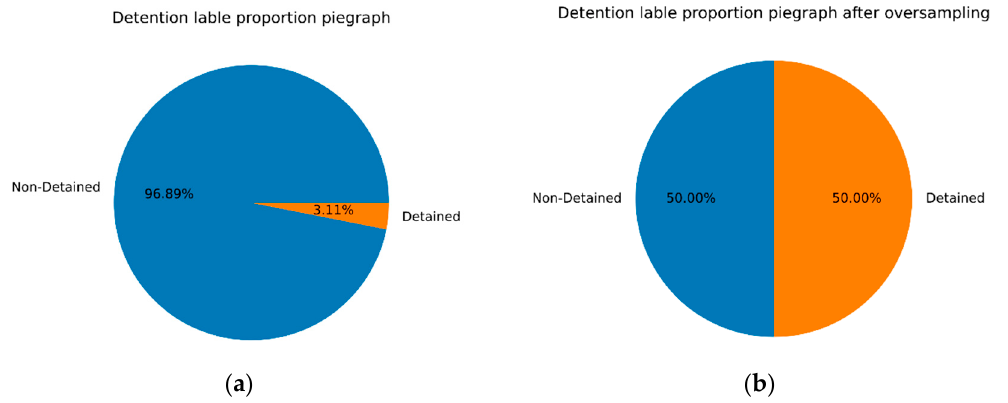
Figure 5. The proportions of classes ( a ) before and ( b ) after SMOTE processing. Table 3. Parameter settings of SMOTE-XGBoost-Ship detention model (SMO-XGB-SD), XGBoost, random forest (RF), support vector machine (SVM), and logistic regression (LR) algorithms.